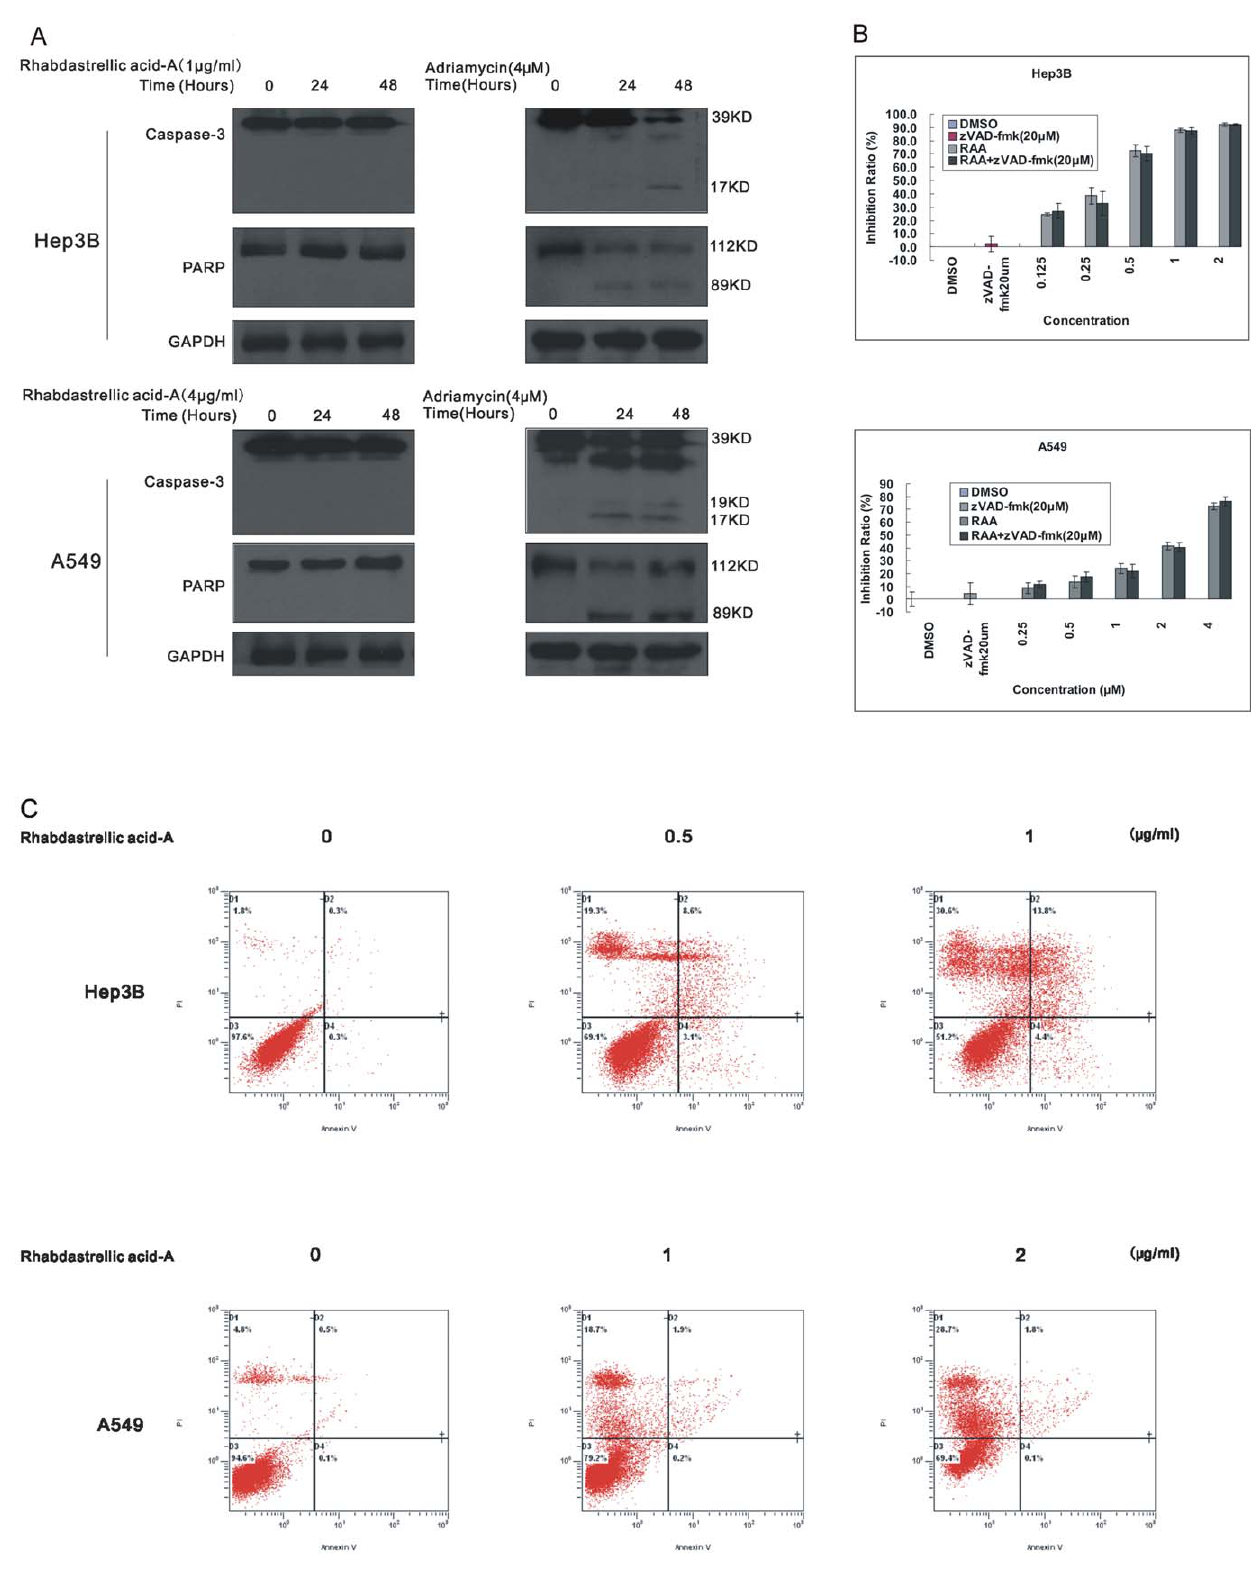
Figure 3. Rhabdastrellic acid-A induced caspase-independent cell death in Hep3B and A549 cells. A. in Hep3B and A549 cells, Cell lysates were prepared from 0.1% DMSO, 1 m g/mL Rhabdastrellic acid-A or 4 m M adriamycin for 24 h and 48 h. Western blot analysis was conducted with caspase-3 and PARP antibodies. B. Cells were incubated with various concentrations of Rhabdastrellic acid-A in the presence or absence of 20 m M z-VAD-fmk for 3 d. MTT assay was conducted. Results (mean 6 S.E.) represent the average of three experiments. C. Hep3B and A549 cells were treated with 0 to 4 m g/mL Rhabdastrellic acid-A for 48 h. After treatment, the cells were collected sequentially and stained with Annexin V and PI and analysed by the flow cytometry assay.